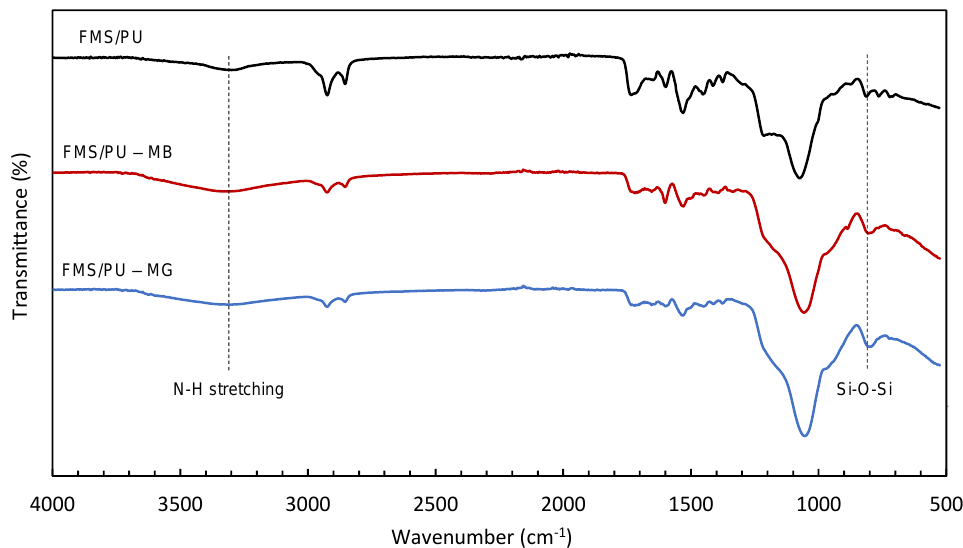
Figure 10. FTIR spectra of FMS/PU, FMS/PU − MB, and FMS/PU − MG.